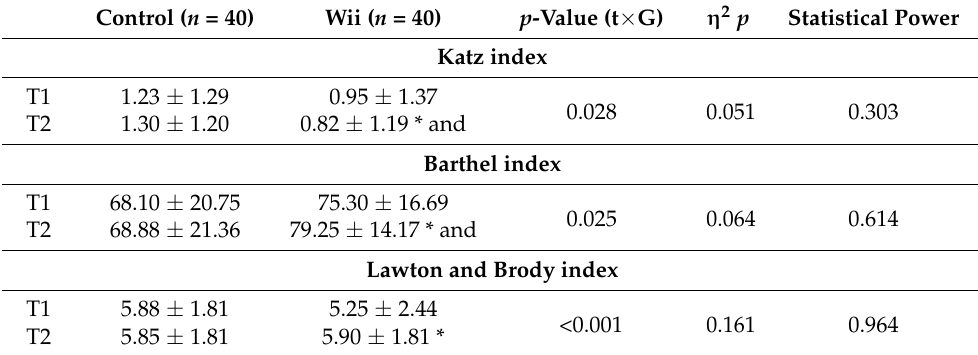
Table 2. Activities of daily living (ADLs) data of the control group and Wii group before and after the